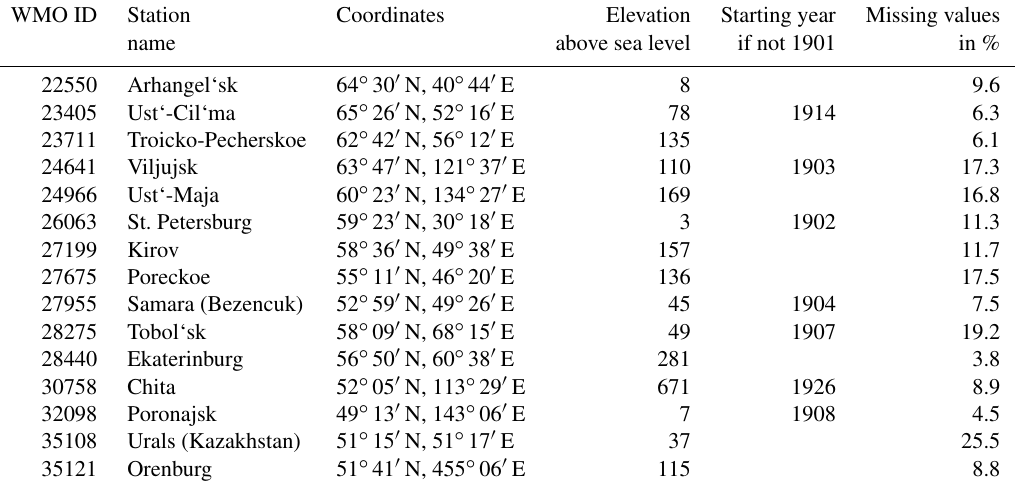
Table 2. Fifteen long-term snow stations taken out of the Russian snow station data pool. Listed are WMO (World Meteorological Organi- zation) ID, name, coordinates, and elevation as well as starting year and missing values. Missing values are indicated relative to the whole sample size of each individual station as average of April, October and